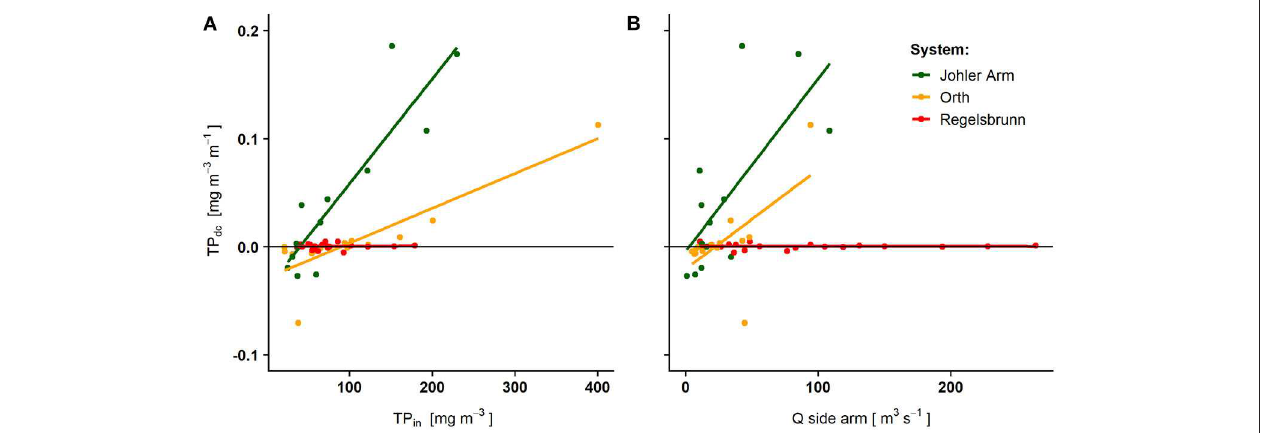
FIGURE 2 | Significantly increasing measured concentration differences ( n = 54) of total phosphorus with increasing incoming total phosphorus concentration (A) and discharge (B) along the three differently connected side arm systems: Johler Arm (high connectivity, n = 17), Orth (medium connectivity, n = 16), and Regelsbrunn (low connectivity, n = 21). Positive values indicate net retention and negative value release of TP between two sampling points. For details on the deduction of the statistical approach, please refer to the Supplementary Information .